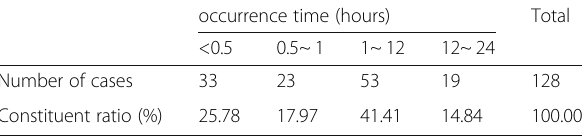
Table 6 The time distance of ADR occurrence time and the last medication time of XSTI